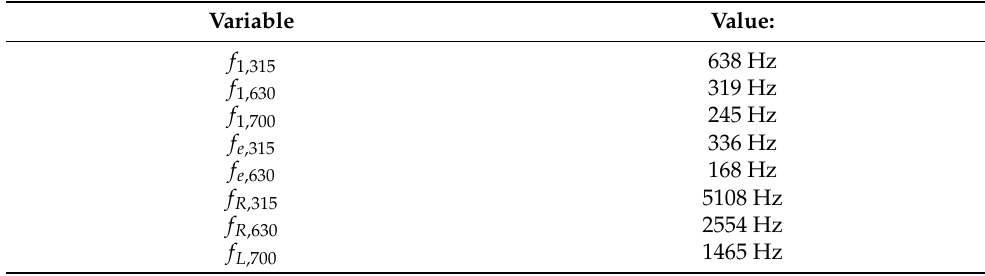
Table A2. Calculated frequency values depending on the size and shape of the ventilation duct.